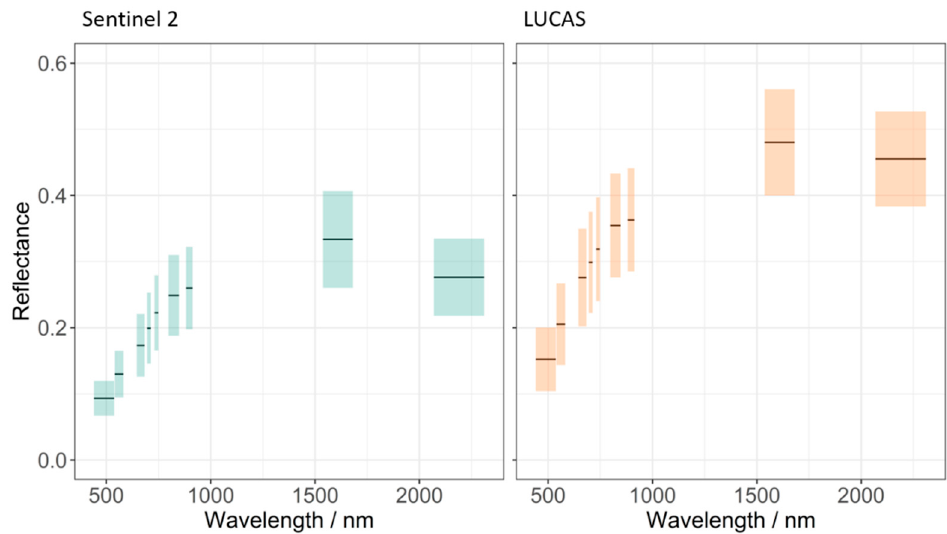
Figure 7. Median reflectance values of selected locations masked out as bare soil pixels (light green); and the corresponding spectral signatures of LUCAS library (orange) for 10 Sentinel-2 bands. The horizontal solid black lines indicate the median values, while the heights of the boxplots correspond to the standard deviation.